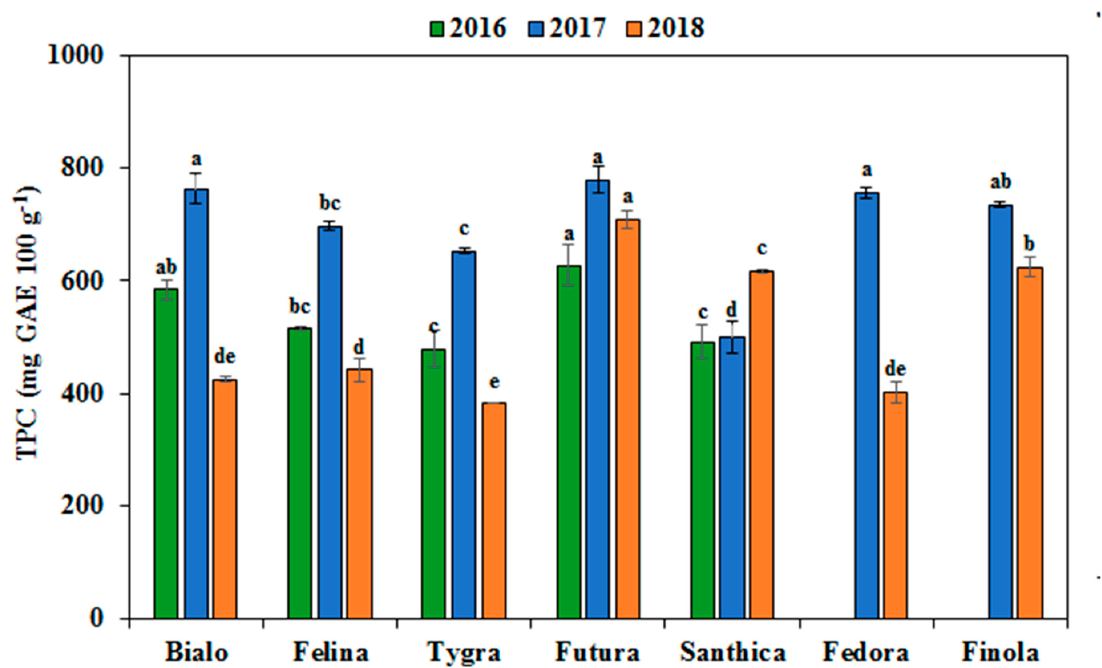
Figure 2. Total phenolic content (TPC) of hemp seeds from the seven industrial hemp cultivars cultivated in this study for three growing seasons (2016, 2017, and 2018). For each year, means within the column in the same color followed by the same letter are not significantly different ( p > 0.05).